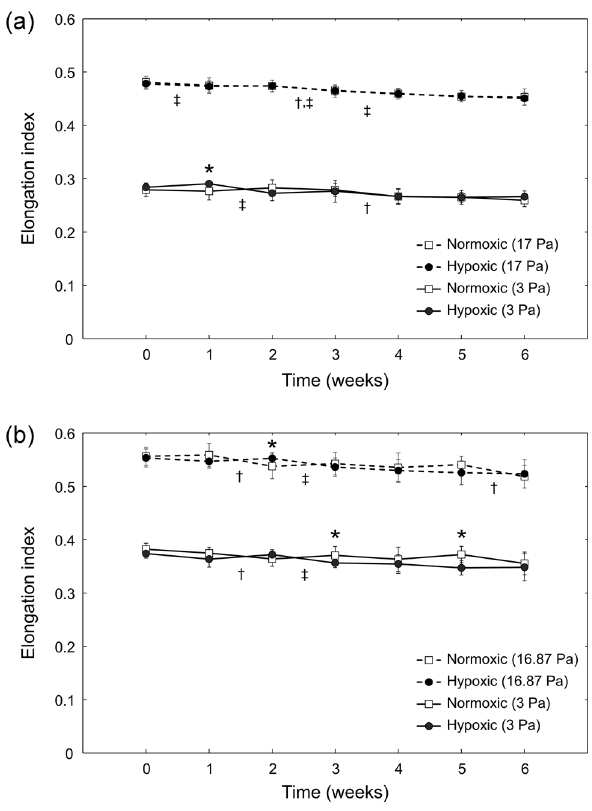
Figure 2. Elongation index (EI) measured using ektacytometry for RBCs stored under normoxic and hypoxic conditions over the course of 6-week hypothermic storage. ( a ) EI measured using RheoScan-D ektacytometer for two levels of shear stress (3 Pa and 17 Pa). Values shown are mean ± standard deviation (n = 5). ( b ) EI measured using LORRCA ektacytometer for two levels of shear stress (3 Pa and 16.87 Pa). Values shown are mean ± standard deviation (n = 4). Statistically significant differences ( p < 0.05) between normoxic and hypoxic storage of the same duration are marked by an asterisk (*). Statistically significant differences ( p < 0.05) between subsequent weeks of storage are marked by a dagger (†) for normoxic, and a double dagger (‡) for hypoxic